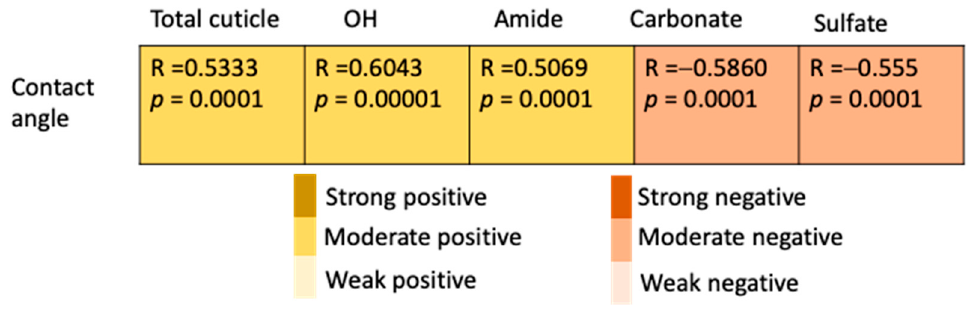
Figure 6. The correlation between the contact angle and the cuticle chemical components as quantified by AFT-FTIR spectroscopy. The correlations were established using a linear regression (Y i = β 0 + β 1 X i ) in a curve fitting model using excel. The color coding determines a weak, moderate, or strong correlation between each chemical component of the cuticle.